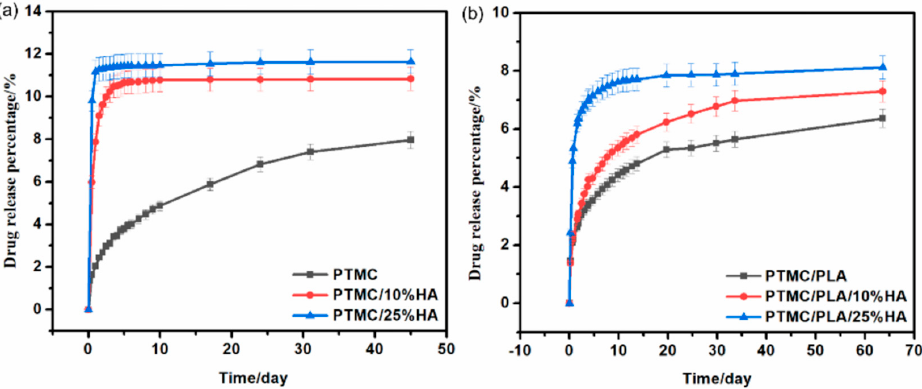
Figure 6. Release profiles of DOX from PTMC/HA ( a ) and PTMC/PLA/HA ( b ) scaffolds. Compared with DOX-incorporated pure PTMC scaffolds, DOX-incorporated PTMC/HA and PTMC/PLA/HA scaffolds showed faster drug-release rates, presumably due to the increased drug diffusion coefficient of PTMC/HA and PTMC/PLA/HA scaf- folds. Moreover, the release rate increased along with an increase in HA content. The cu- mulative percentage release of PTMC/10%HA and PTMC/25%HA scaffolds reached 10.8% and 11.6%, respectively, and higher than that of pure PTMC scaffolds (8.0%), after 45 days of drug-release. The cumulative percentage release of PTMC/PLA/10%HA and PTMC/PLA/25%HA scaffolds reached 7.3% and 8.1%, respectively, and higher than that of PTMC/PLA scaffolds (6.4%), after 55 days of drug-release. This result indicated that